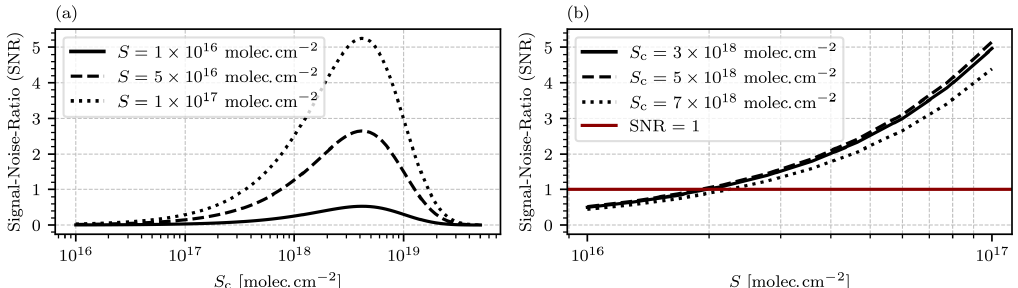
Figure 6. (a) Modeled SNR as a function of the cell column density S c for different choices of the target gas column density S . The highest SNR is reached for a cell column density of approximately S c ≈ 4 · 10 18 molec.cm − 2 , with a slight dependence on S . (b) Modeled SNR as a function of the column density of the target gas S for different choices of the cell gas column density S c . The red vertical line marks SNR = 1 and thus the detection limit of the instrument.